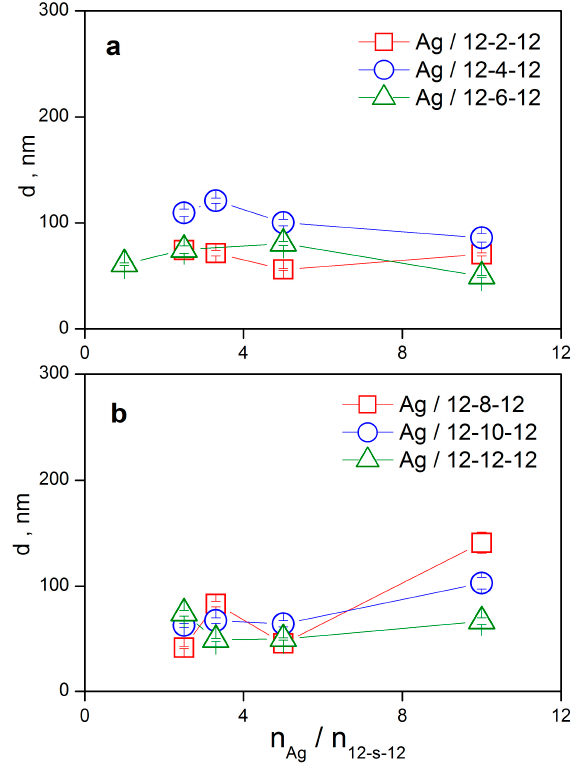
Figure 6. Size d of silver nanoparticles stabilized with gemini surfactants 12- s -12 with the spacer length s = 2–12 methylene groups as a function of the molar ratio values n Ag /n 12- s -12 .